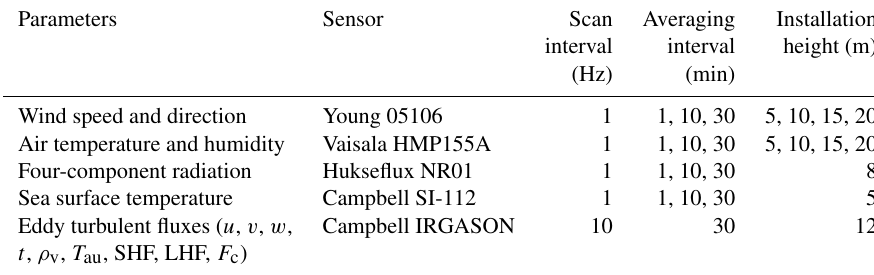
Table 1. List of sensors installed on the YXASFT and their specifications. Parameters